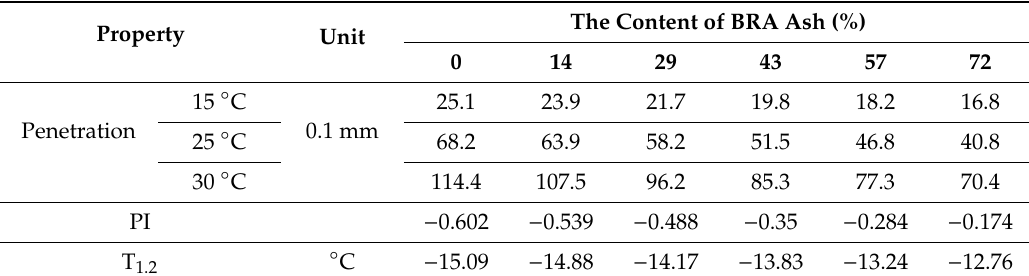
Table 7. Penetration test results of the BRA ash asphalt mortar.